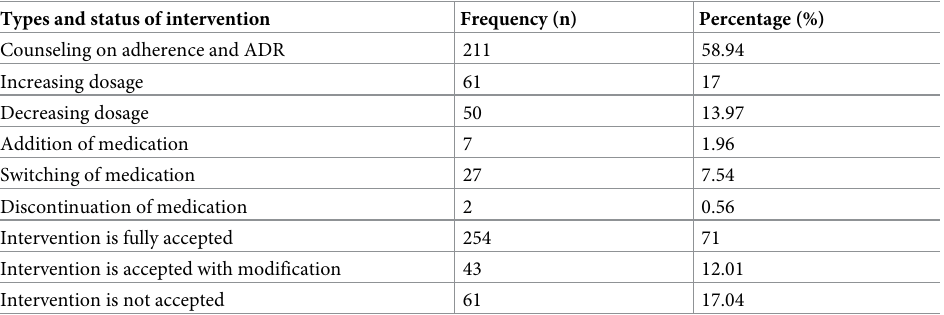
Table 5. Types and status of intervention provided for epileptic patients attending ambulatory clinic of JMC, 2021. Types and status of intervention Frequency (n) Percentage (%) Counseling on adherence and ADR 211